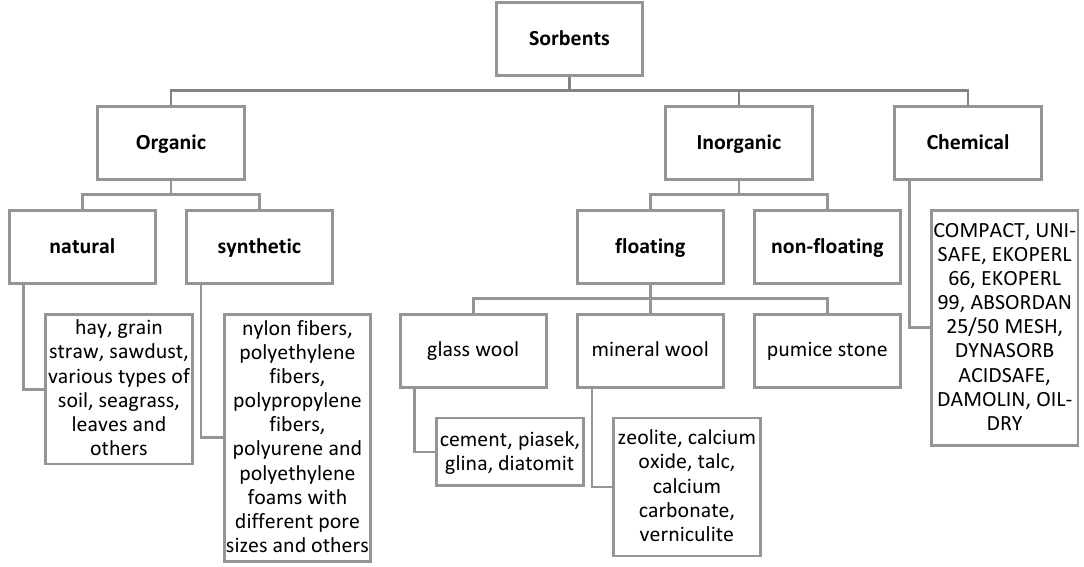
Figure 8. Types of sorbents. Own compilation based on literature data [104].